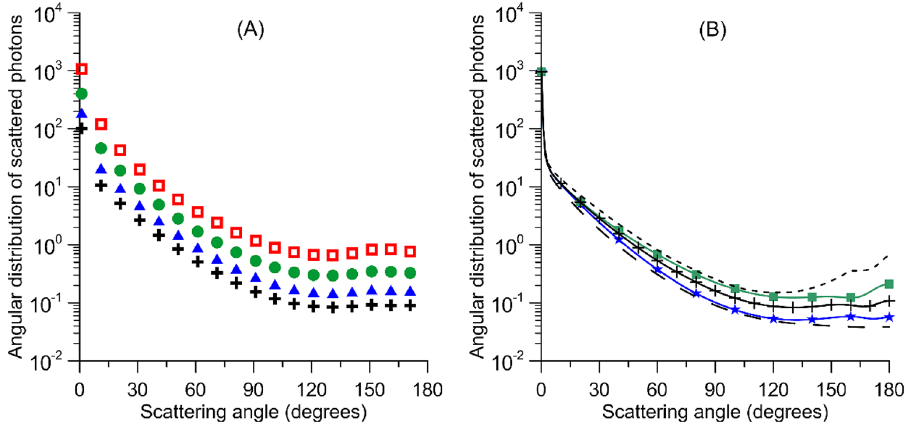
Figure 1. Angular distribution of scattered light intensity for light of wavelength (λ) 530 nm computed for a mixture of urban-dominated aerosol components (details are discussed in “Methods”). The number of scattered photons proportional to the differential scattering cross section 39 is shown on y-axis relative to the number concentration of urban aerosols 36 . ( A ) Black crosses in the left plot indicate results for the baseline conditions. The plot demonstrates that an increase of the particle size by 20% (solid blue triangles), 50% (solid green circles), and 100% (hollow red squares) over baseline while holding the number concentration constant enhances the scattered light intensity in all directions. ( B ) The range of backscattering features due to the varying complex refractive index ( m = n + i κ ). The baseline conditions are for a mean refractive index m = 1.5 + 0.05i (solid black line with cross symbols). The scattered intensity drops when lowering n to 1.4 (blue stars) and increases when n is raised to 1.6 (green squares). Highly absorbing elements in the aerosol mixture flatten the scattering phase function at large angles (long dashed black line for κ = 0.2), which is contrasted by the results for non- absorbing particles (short dashed black line for κ =